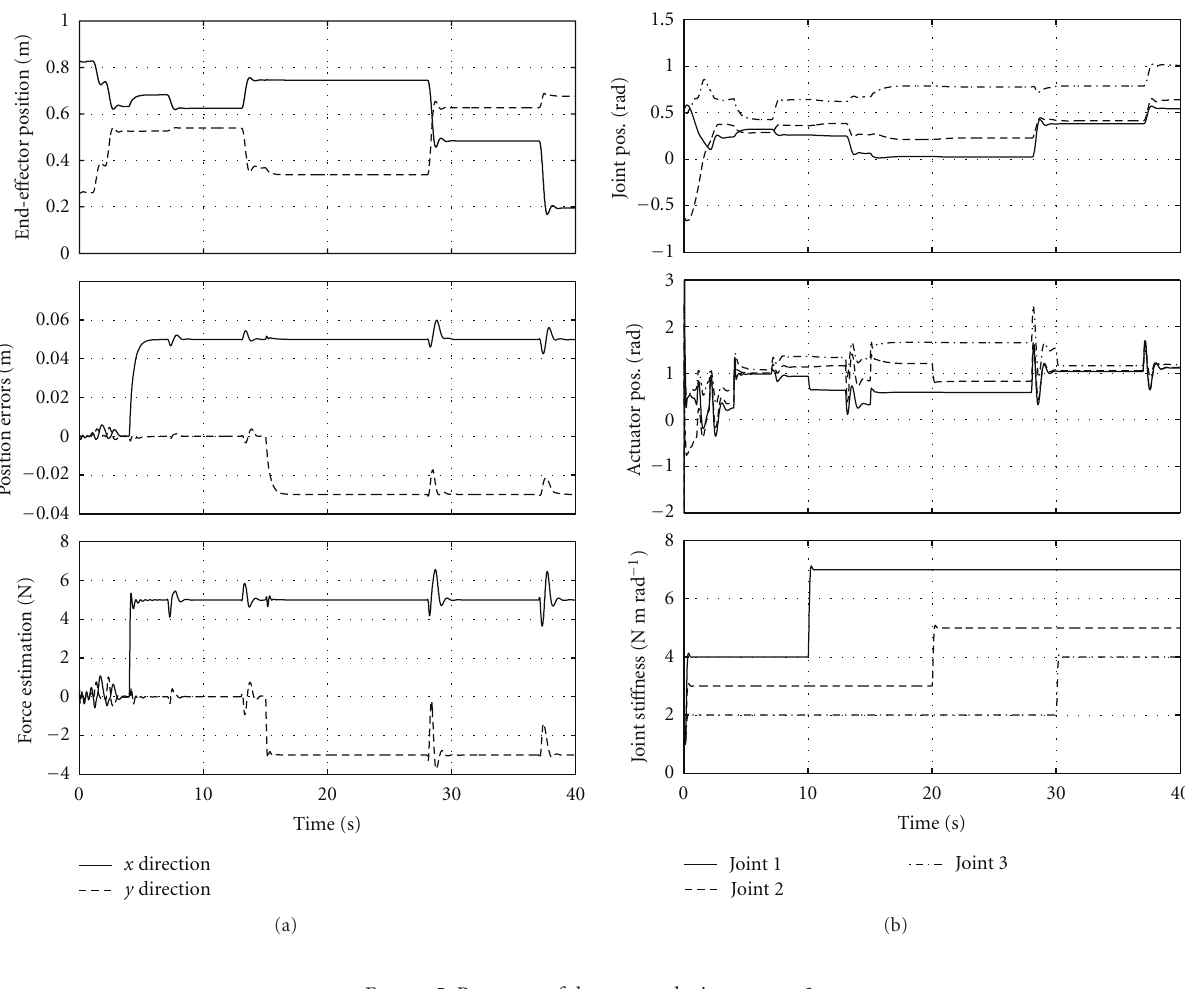
Figure 5: Response of the system during test no.